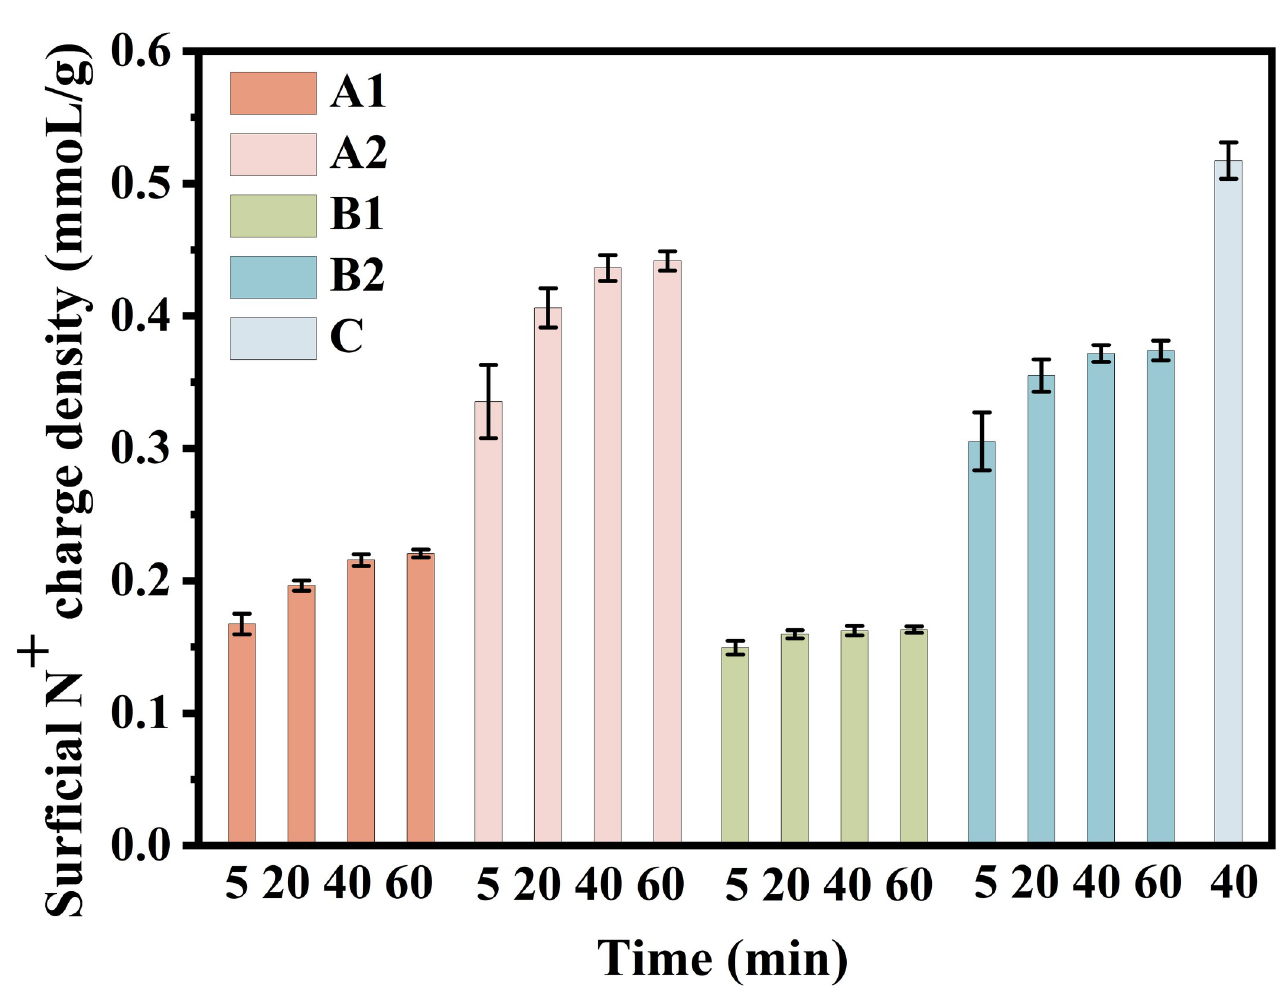
Fig 1. Optimization of detection method of surficial N + charge